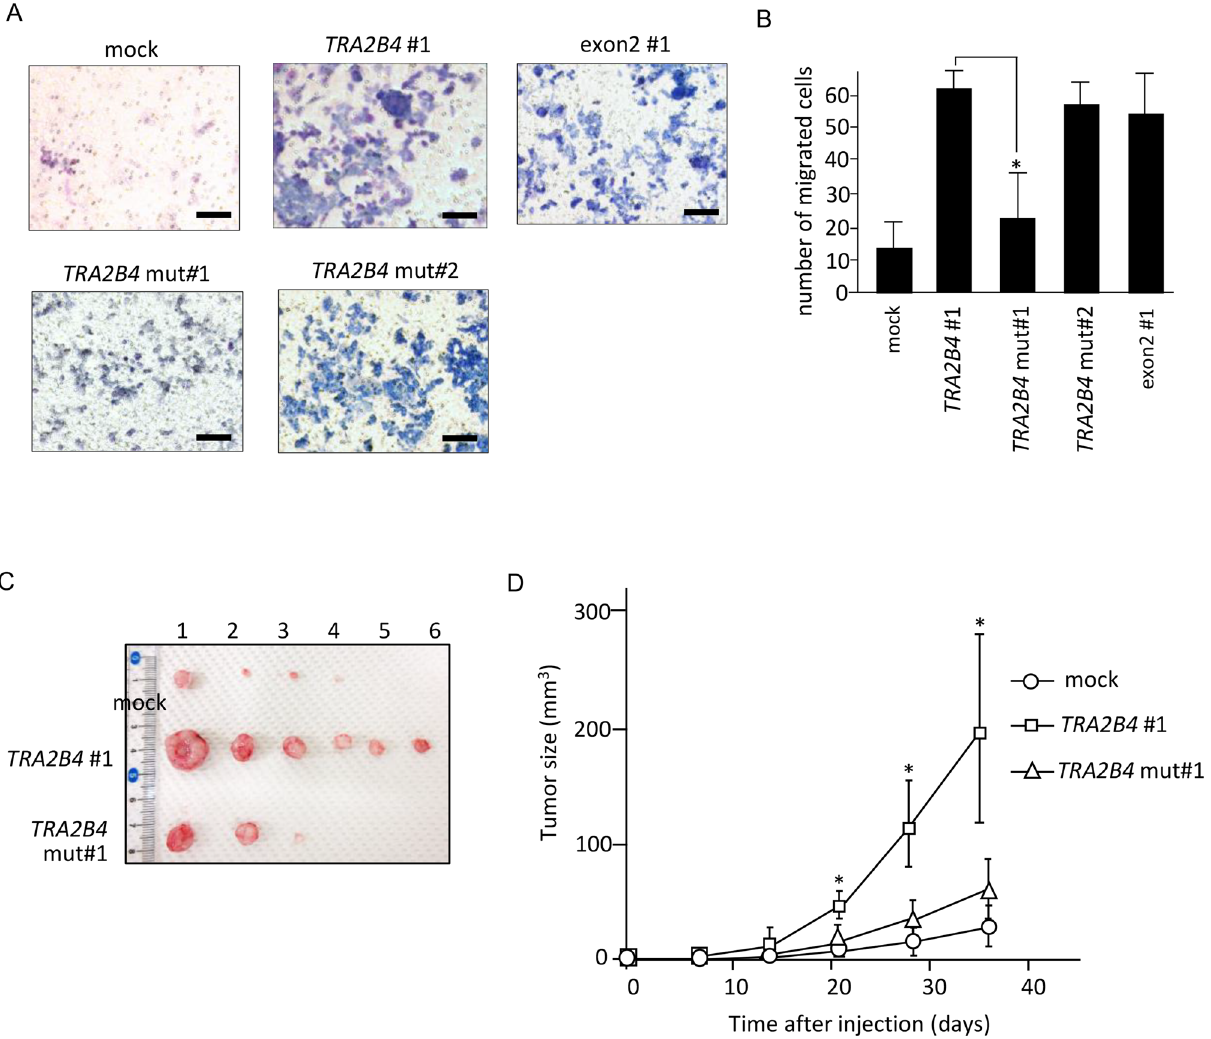
Figure 6. Effect of uc.138 on cell migration and tumor progression. ( A ) Transwell migration assays were performed using human colorectal carcinoma (HCT116) cells with stable overexpressed TRA2B4 , exon 2, TRA2B4 mut#1, or TRA2B4 mut#2. Migrated cells were stained by a Diff-Quick staining kit. ( B ) Quantification of cell migration was expressed by cell counting. Values represent mean ± SD (n = 8). *Significant difference versus TRA2B4 #1 (unpaired Student’s t test, p < 0.05). ( C ) Images of the tumors from the mice injected with cells which were stably overexpressed TRA2B4 , TRA2B4 mut#1, or mock. ( D ) Tumor size in nude mice injected with HCT116 cells was measured every 7 days. Values represent mean ± SD (n = 6). *Significant difference versus mock (unpaired Student’s t test, p <